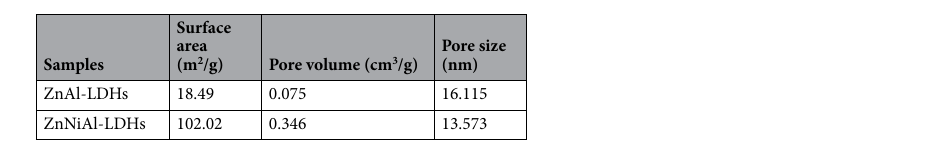
Table 1. The BET characterization results of ZnAl-LDHs and ZnNiAl-LDHs.